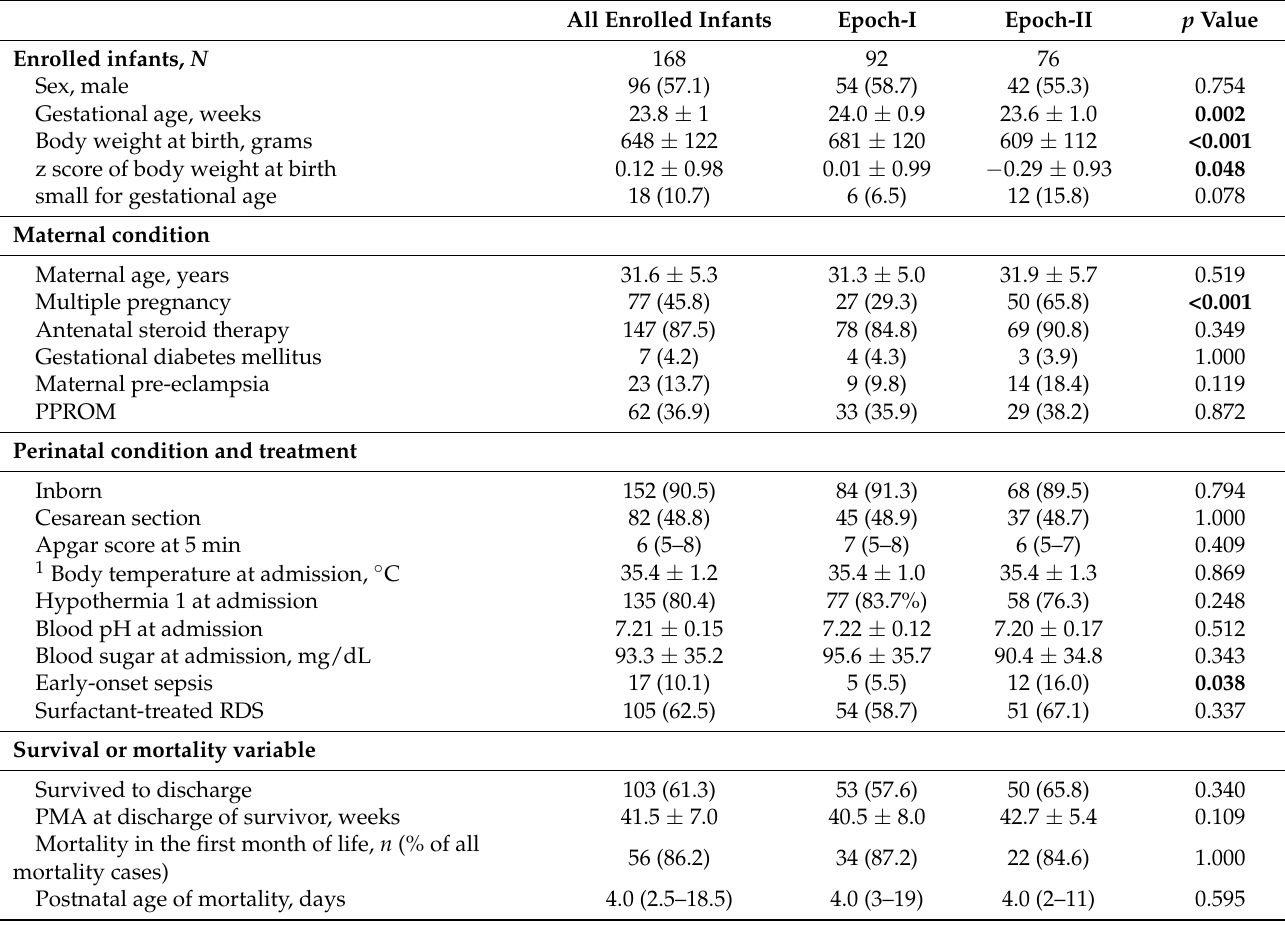
Figure 1. A flow chart showing the enrollment scheme. GA: gestational age. Table 1. Clinical characteristics of infants enrolled in this study.